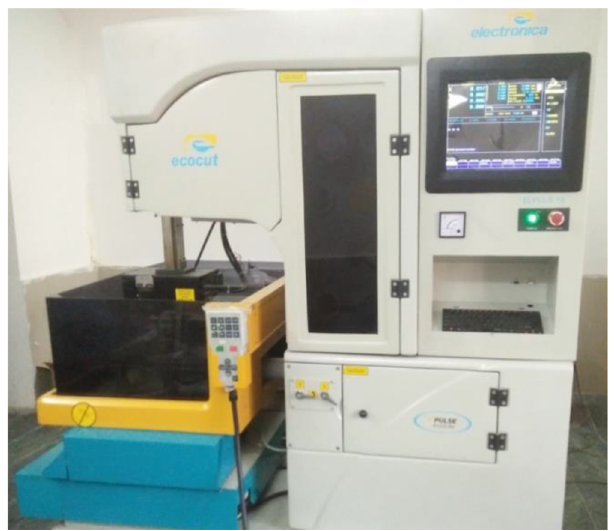
Fig. 1. Experimental set up.